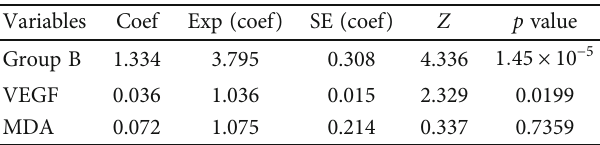
Table 4: Cox regression showing variables that in fl uence the development of DWR to